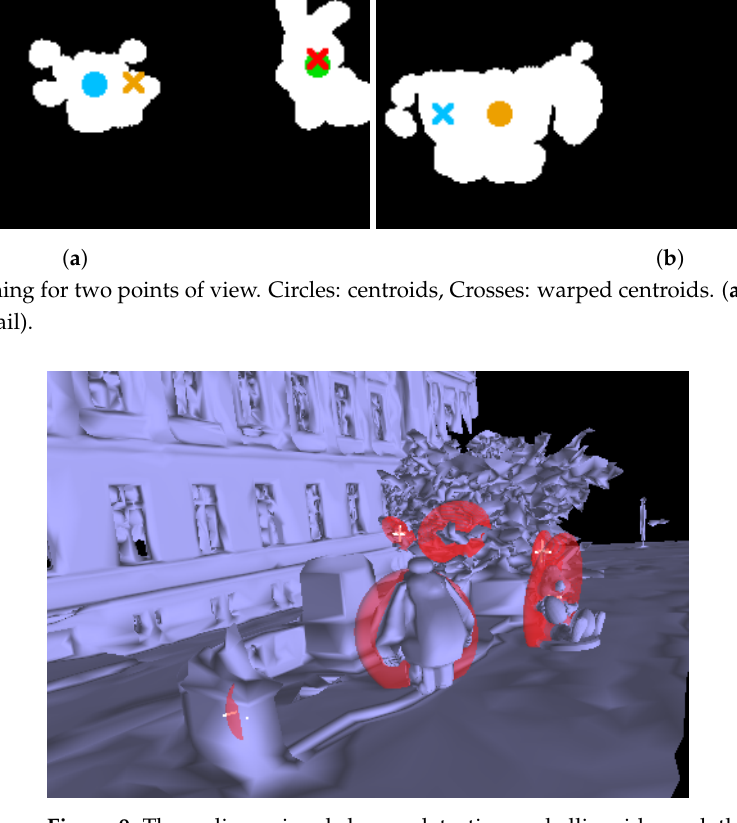
Figure 9. Three-dimensional change detection; red ellipsoids mark the estimated location and size of